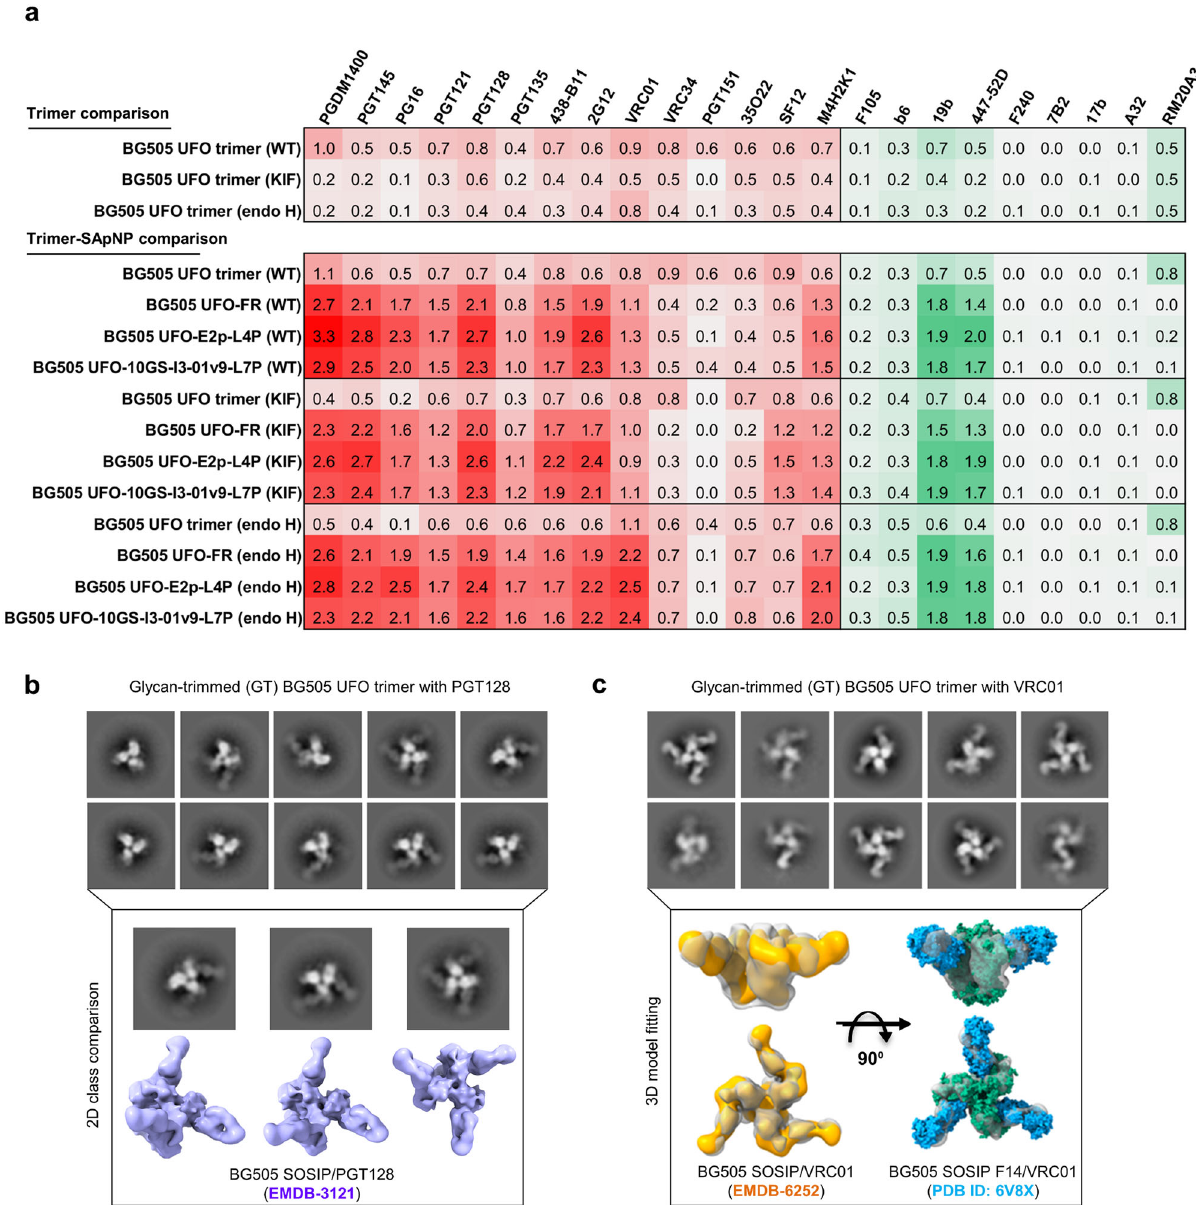
Fig. 4 | Antigenicity of BG505 UFO Env immunogens with wildtype and mod- i fi edglycans.a Antigenicpro fi lesofBG505 UFOtrimer (top)and itsthree SApNPs based on FR, E2p-L4D, and I3-01v9-L7P (bottom) with different glycan treatments (wildtype,expressedinthepresenceofkifunensine,andendoHtreatment).Atotal of 14NAbs/bNAbsand 9non-NAbsweretestedbyBLI.Sensorgramswereobtained from an Octet RED96 using an antigen titration series of six concentrations (starting at 266.7nM for the UFO trimer, 14.9nM for the FR SApNP, 5.5nM for the E2p and I3-01v9 SApNPs followed by two-fold dilutions) and are shown in Fig. S4. The peak values at the highest concentration are summarized in the matrix, in which cells are colored in red and green for (b)NAbs and non-NAbs, respectively.